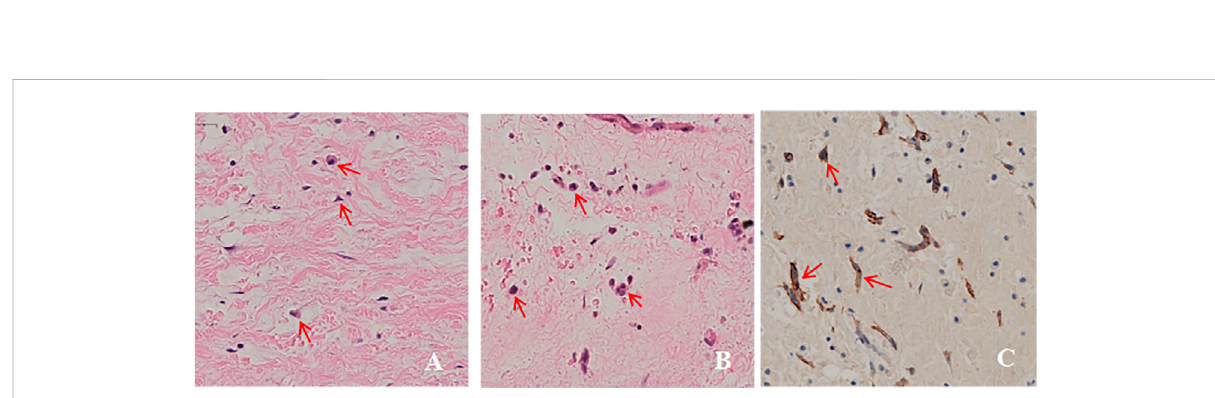
FIGURE 4 Histopathological images. (A,B) . Ear tumor of the proband and his sister was composed of tumor cells in a mucous matrix (hematoxylin-eosin, original magni fi cation ×200). (C) . Immunohistochemical analysis of paraf fi n-embedded cardiac myxoma tissue from the proband showing tumor cells (brown)